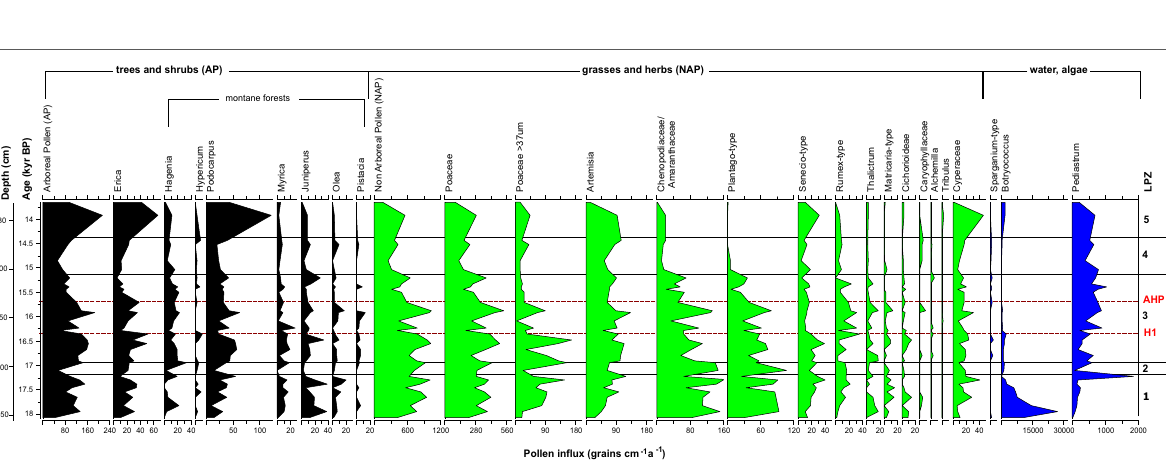
Fig. 7 Pollen influx diagram of selected taxa and algae from B4 depression, showing pollen accumulation rate in grains cm − 1 year −